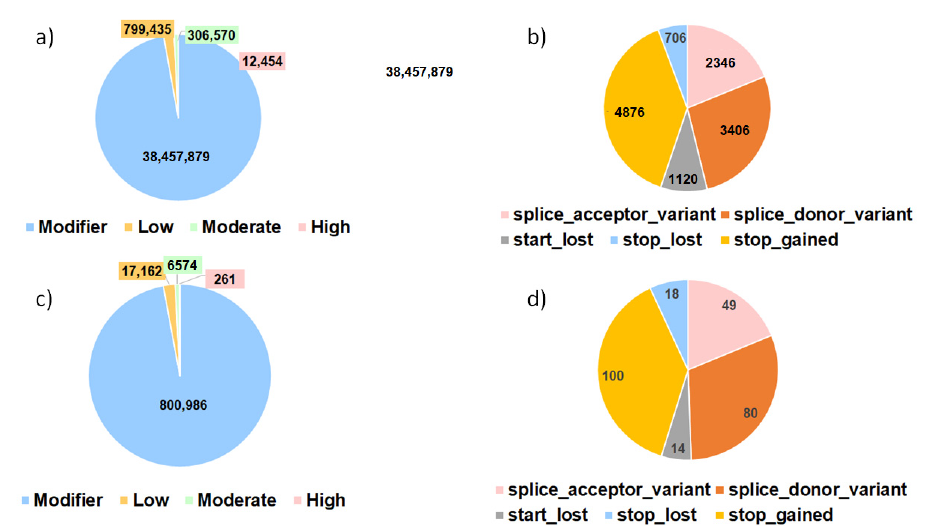
Figure 5. Proportion of variants detected (%) in the variant e ff ect analyses for all the SNPs detected in the variant calling ( a , b ) and the variants identi fi ed in the detected outlier regions from the F